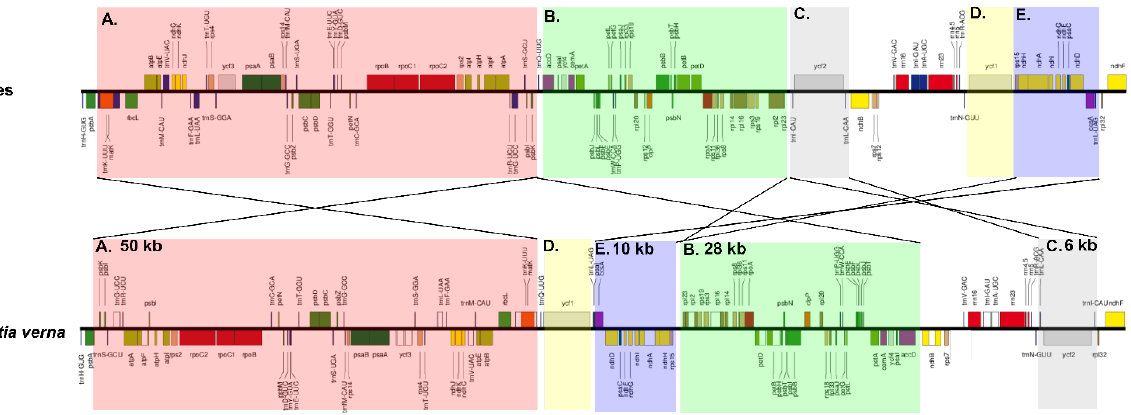
Figure 4. Comparison of the chloroplast genome structures of two Tibetia species with G. verna . The ( A – C , E ) boxes indicate approximately 50 kb, 28 kb, 6 kb, and 10 kb, respectively. The ( D ) box indicates the repositioning of the ycf 1 gene.